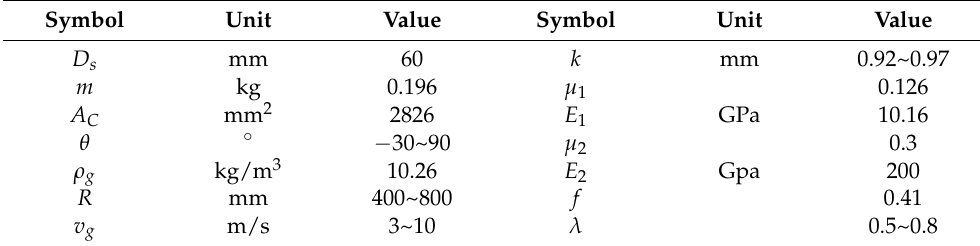
Table 2. Basic parameters of fuel-element